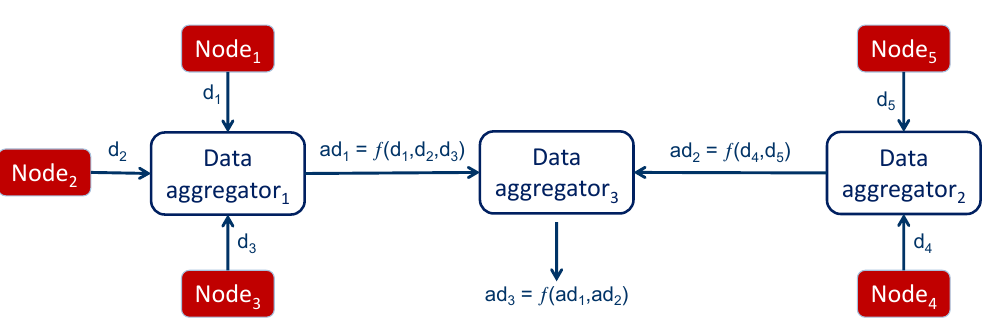
Figure 4. In-network data